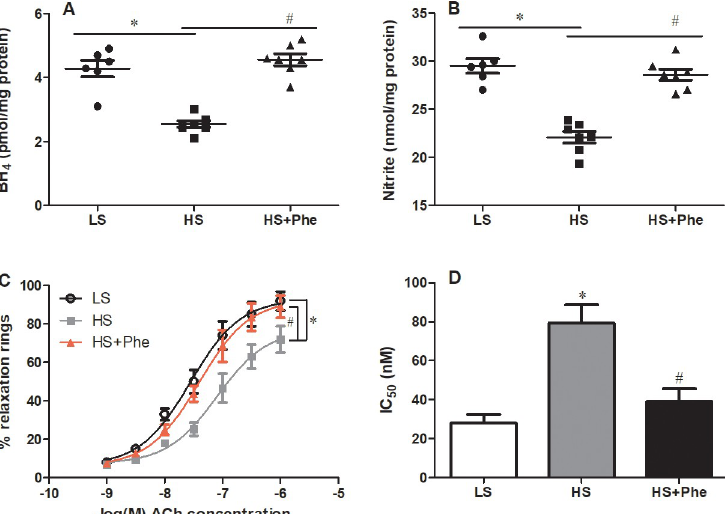
Fig 3. Effects of phenylalanine on BH 4 (A), nitrite (B), vascular reactivity (C), and the corresponding IC 50 value (D) in the aortas of Dahl SS rats fed a low salt or high salt diet. Each value represents the mean ± SEM, n = 6–8, � p < 0.05 vs. LS group, # p < 0.05 vs. HS group.